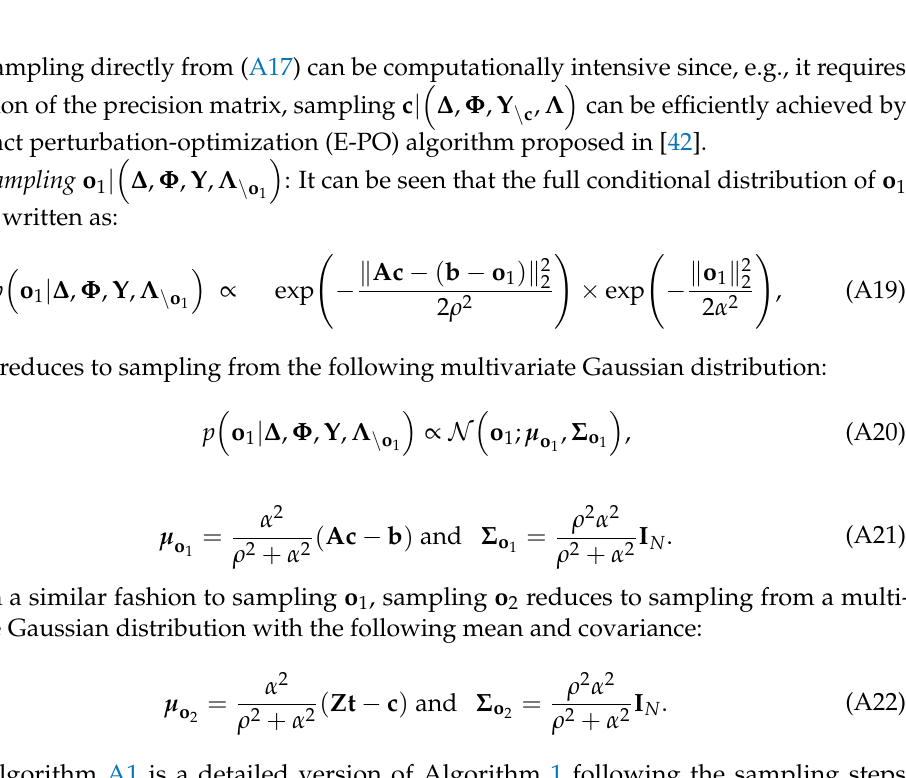
Algorithm A1 is a detailed version of Algorithm 1 following the sampling steps